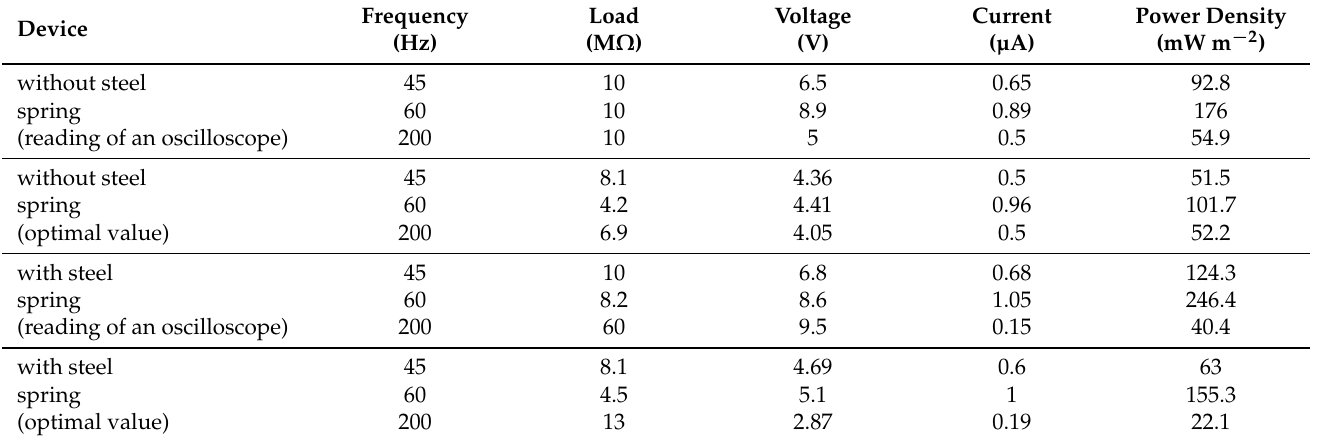
Table 3. Output values and varying resistance loads obtained from the device using PDMS:GO 4%, without steel spring, and with steel spring